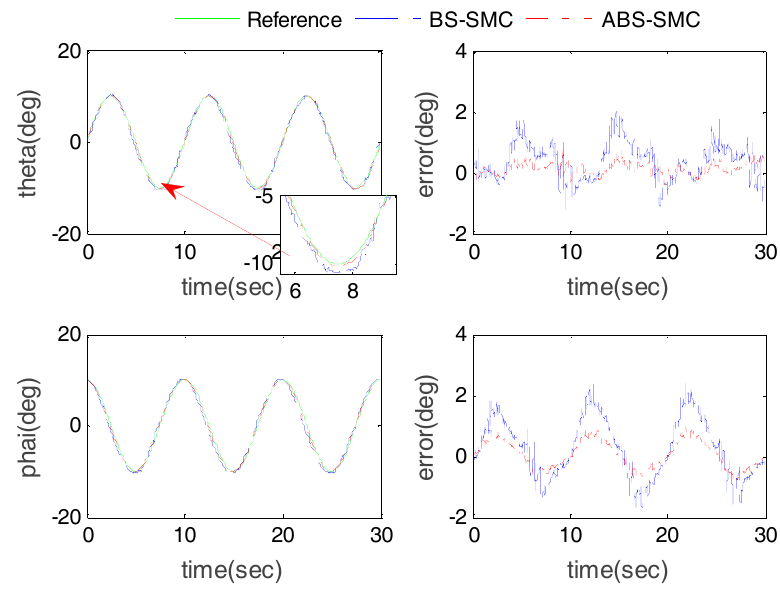
Figure 9. End-effector angle tracking results with subject 1.